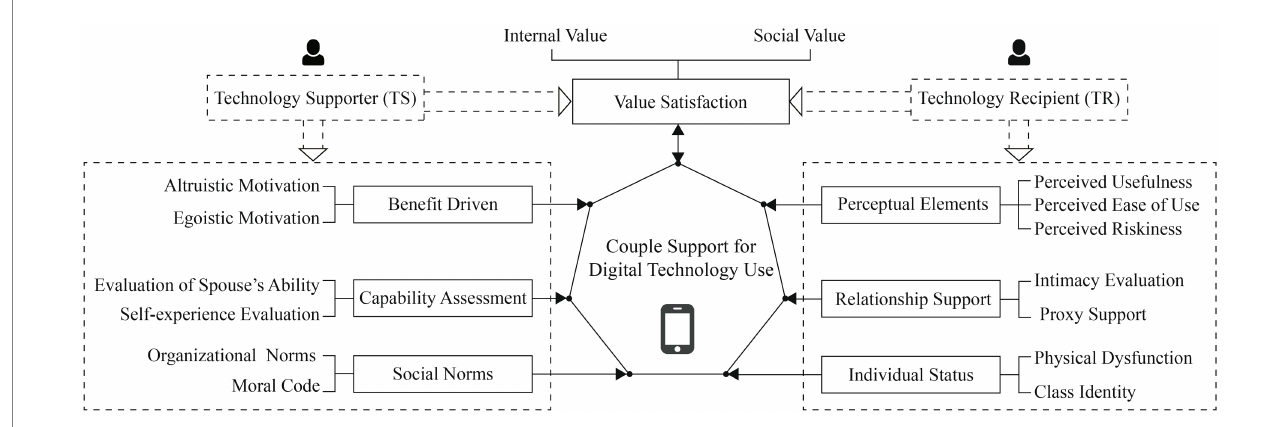
FIGURE 1 A “Motivation”model of couple support for digital technology